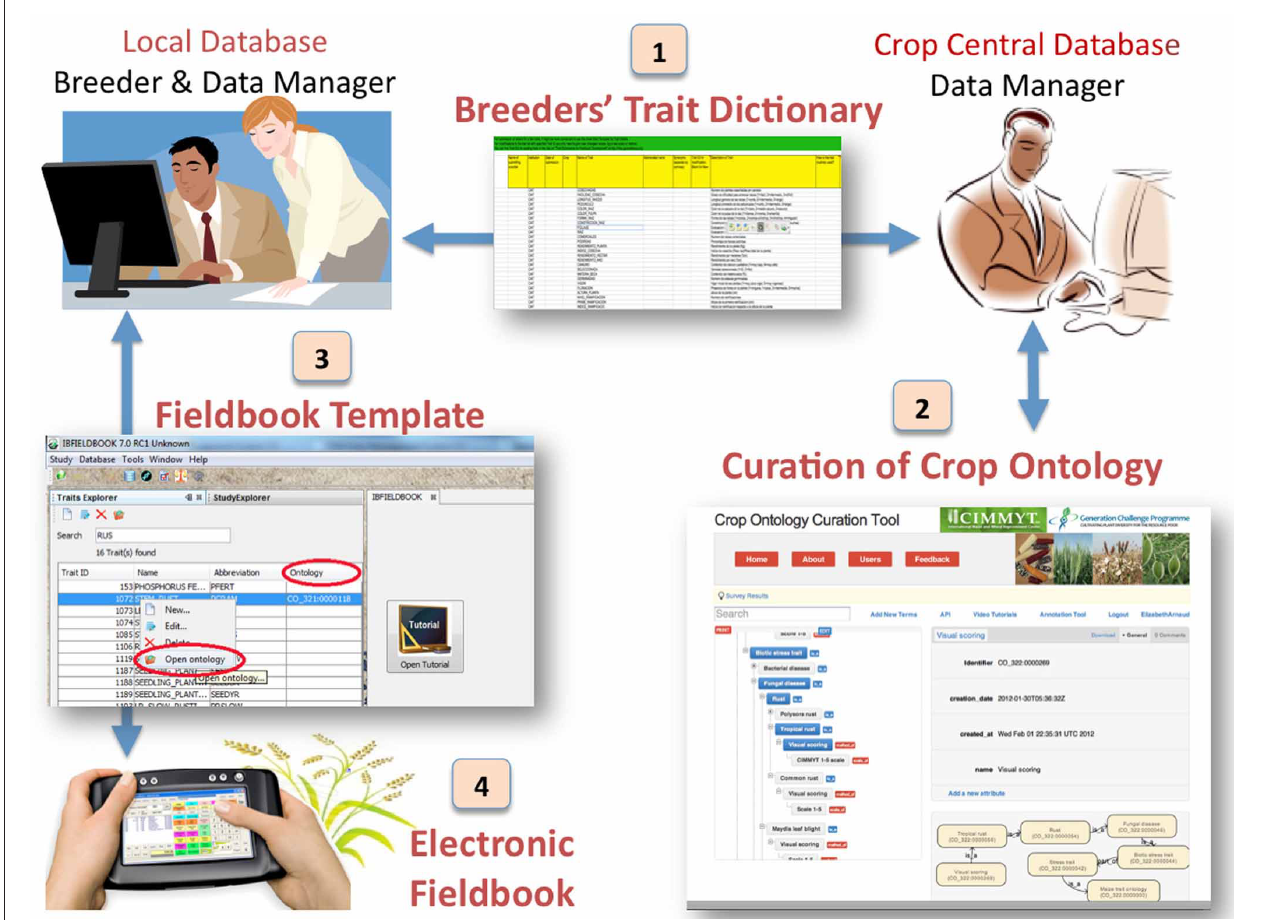
FIGURE 3 | Trait data flow between the ontology, the crop databases and the field book.